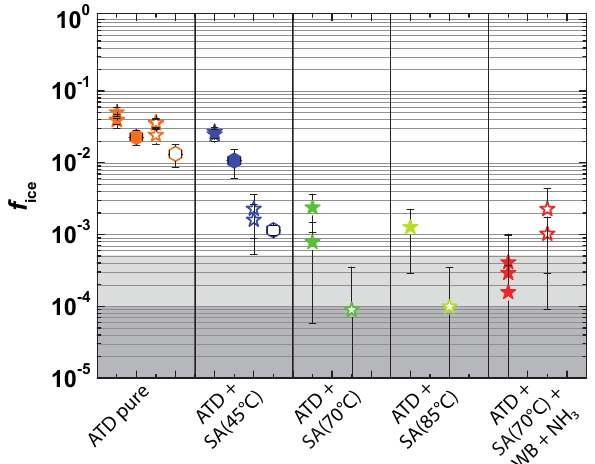
Fig. 5. Comparison between CFDC condensation/immersion freez- ing data (stars) and LACIS immersion freezing results (hexagons) at T =− 30 ◦ C. Measurements without thermodenuder are shown by filled symbols while measurements with thermodenuder are pre- sented as open symbols. The quantification limits of LACIS and CFDC are marked by the light grey and dark grey area, respectively. Where no data from LACIS is given, measured f ice was below the quantification